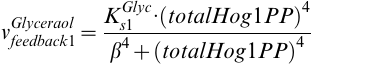
Figure 10. Model predictions of Hog1 responses for the knockouts of different feedback loops involved in glycerol =0 to simulate the knockout of the non- production. We set K Glyc s 1 transcriptional feedback loop (Hog1 kinase, totalHog1PP, dependent) on glycerol production. The simulation results are shown in red curves =0 to simulate the knockout of the in panel B–D. We set K Glyc s 2 transcriptional feedback loop (nuclear phosphorylated Hog1, Hog1PPn, dependent) on glycerol production. The simulation results are shown in blue dotted curves in panel B–D.